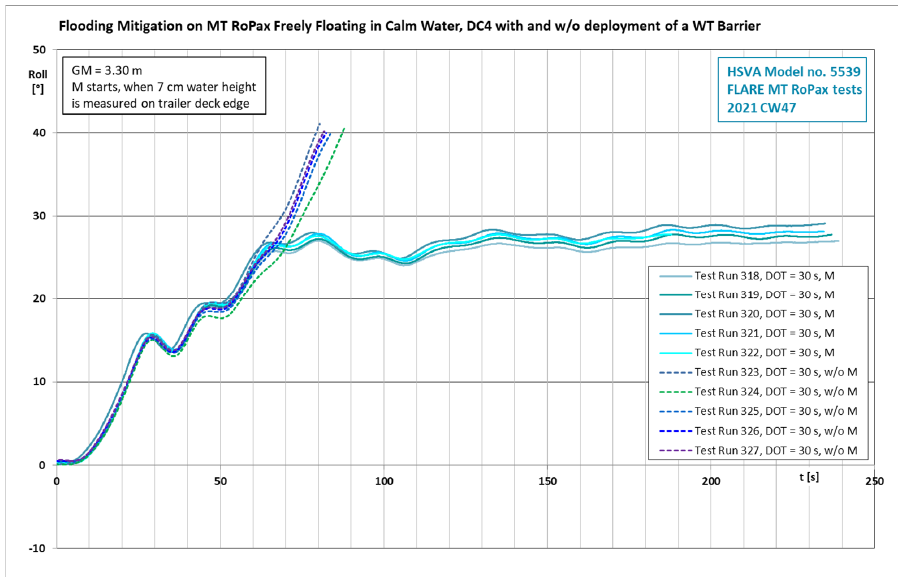
Figure 20. Damage Case 4 with damage opening time 30 s: Roll angle as a function of time with (solid lines) and without (dashed lines) deployment of a watertight barrier on the trailer deck. With GM 3.71 m, the ship survived with flooding mitigation in irregular beam seas with H S 2.5 m in 100% of the cases when the damage was opened in 15 s. Without mitiga ‐ tion, the ship capsized in all cases. With H S 4.0 m, the ship survived with flooding mitiga ‐ tion in 100% of the cases when the damage was opened in 15 s. Without mitigation, the ship capsized in all cases, as before.